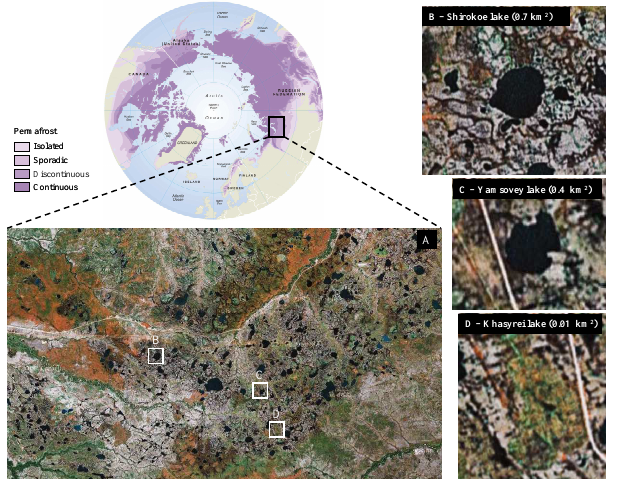
Fig. 1. Map of the study area (Nadym-Pur Interfluve, Western Siberia Wetlands) showing the locations of the three studied lakes. Source for the map of permafrost distribution: International Per- mafrost Association (2003). Images A, B, C, D from GoogleEarth.